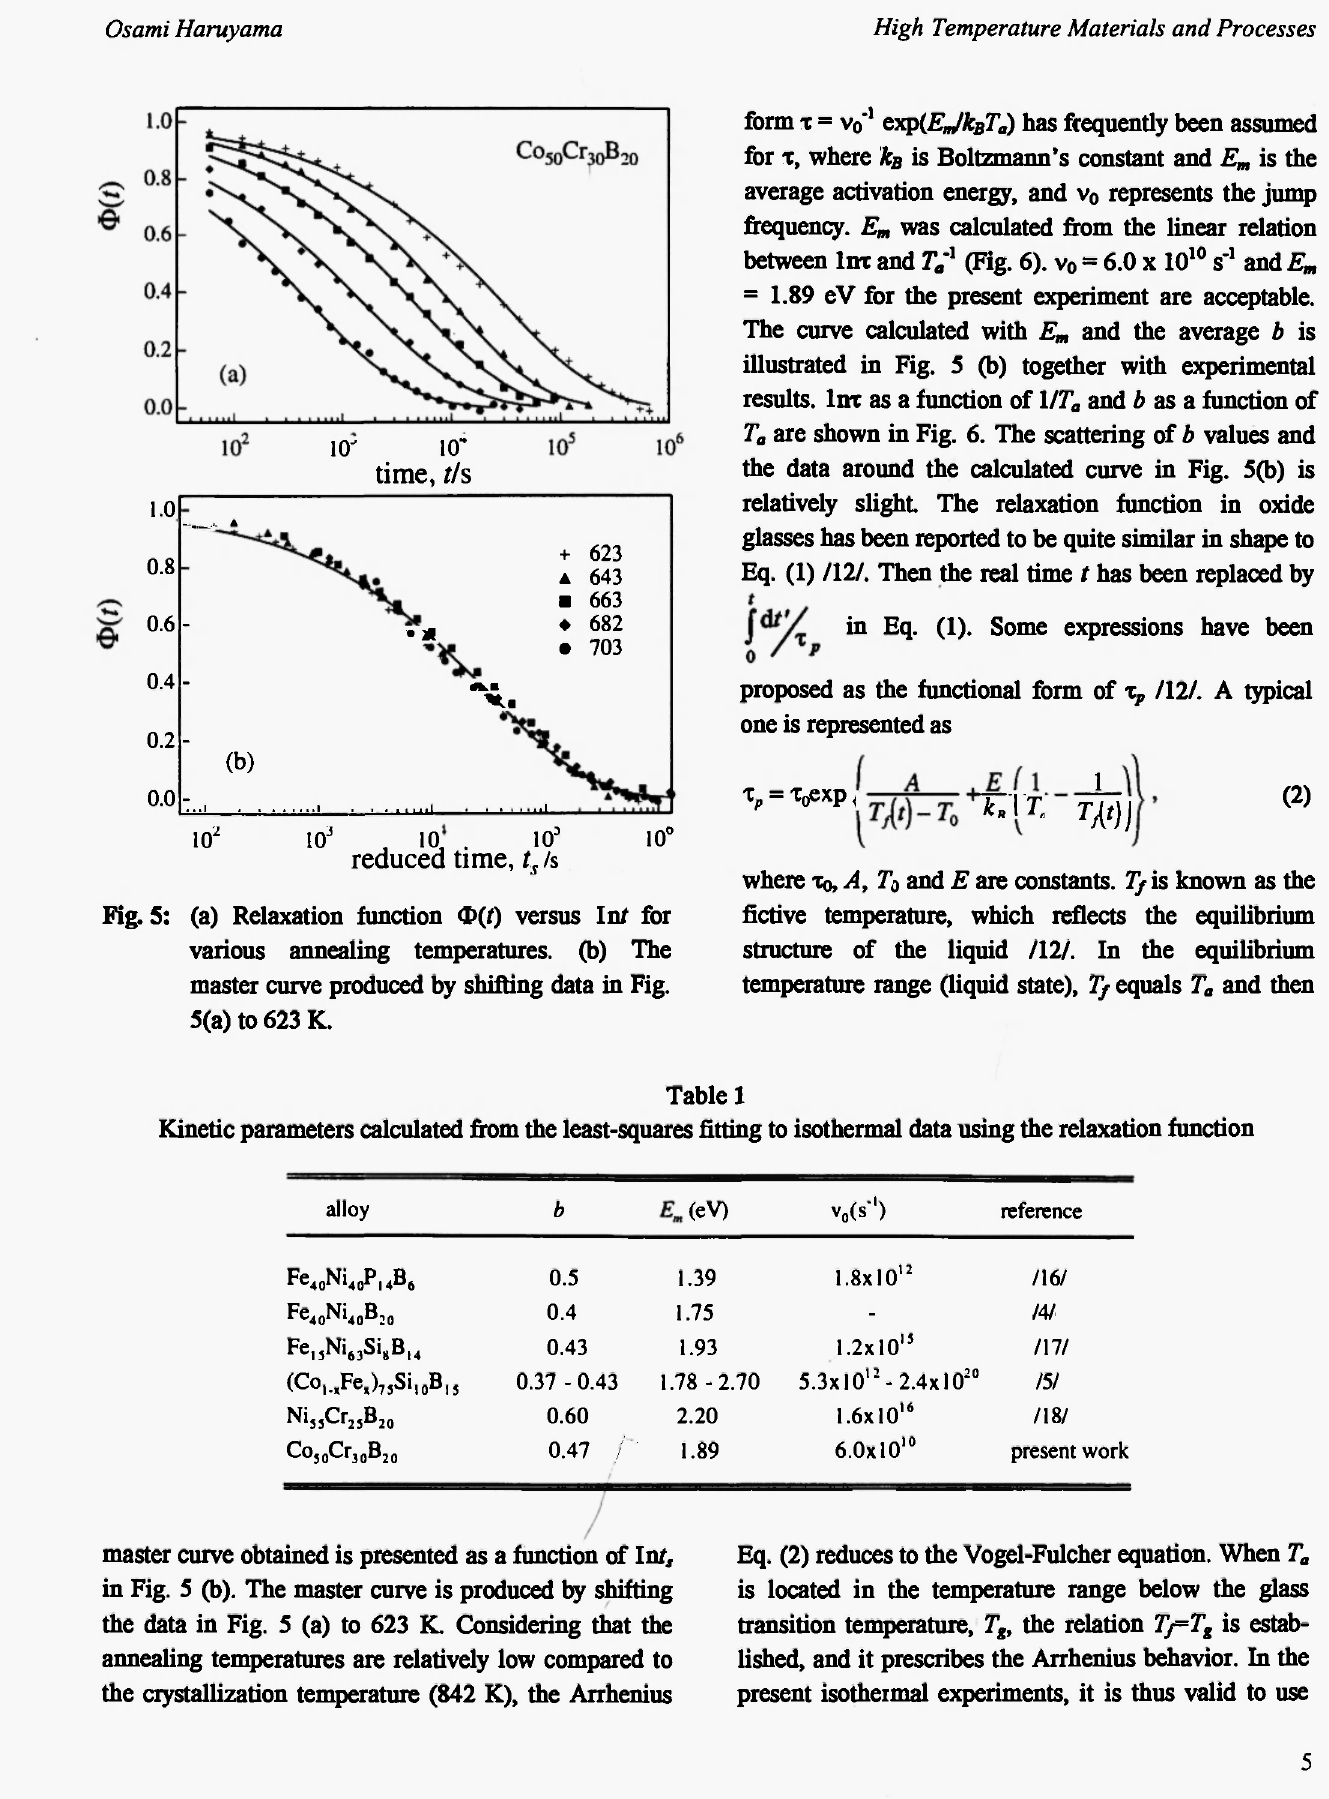
Fig. 5: (a) Relaxation function Φ(ί) versus In/ for various annealing temperatures, (b) The master curve produced by shifting data in Fig. 5(a) to 623 K.